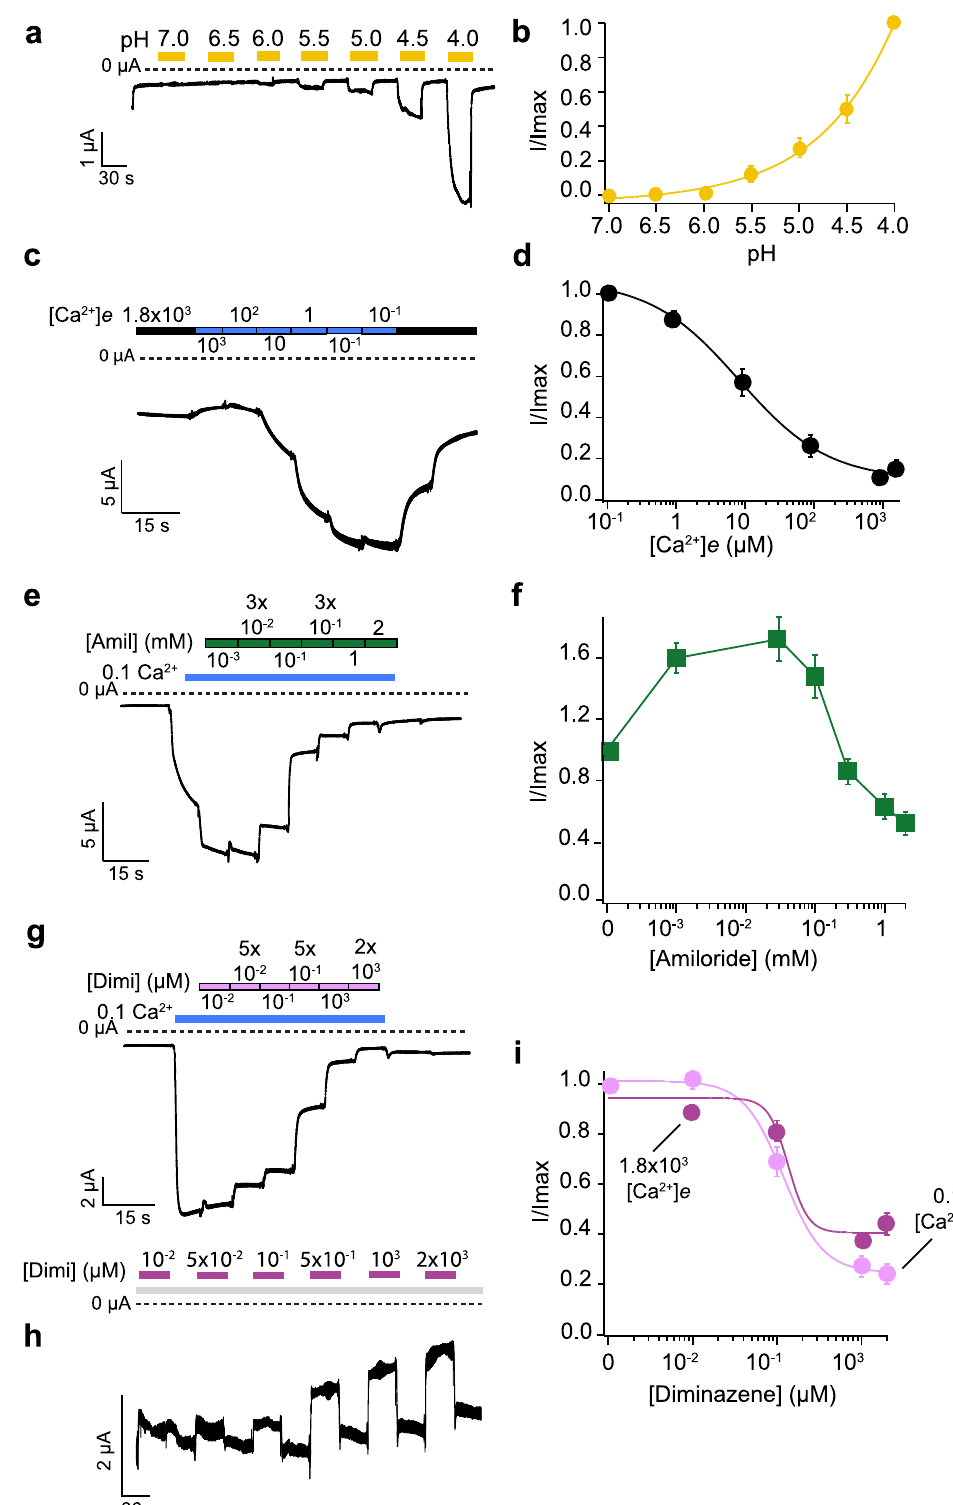
Fig. 4 NeNaC14 is sensitive to high proton concentrations and NeNaC8 is inhibited by extracellular Ca 2 + . a Representative current trace of NeNaC14 being activated by increasingly more acidic pH levels (yellow bars). b pH – response curve. c Representative current trace showing opening of NeNaC8 by lowering [Ca 2 + ] e . [Ca 2 + ] e is indicated in µ M. d Concentration-response curve. n = 15. e Representative current trace showing inhibition of NeNaC8 by amiloride; NeNaC8 was openend by reducing [Ca 2 + ] e to 100 nM (blue line). f Concentration – response curve. n = 11. g Representative current traces showing inhibition of NeNaC8 by diminazene, dissolved in bath solution containing 100 nM Ca 2 + (light pink bars). h Representative current traces showing inhibition of NeNaC8 by diminazene, dissolved in bath solution containing 1.8 mM Ca 2 + (dark pink bars). i Concentration – response curves. n = 14. Error bars represent S.E.M.; Concentration – response curves in b , d , and i were fi tted with the Hill